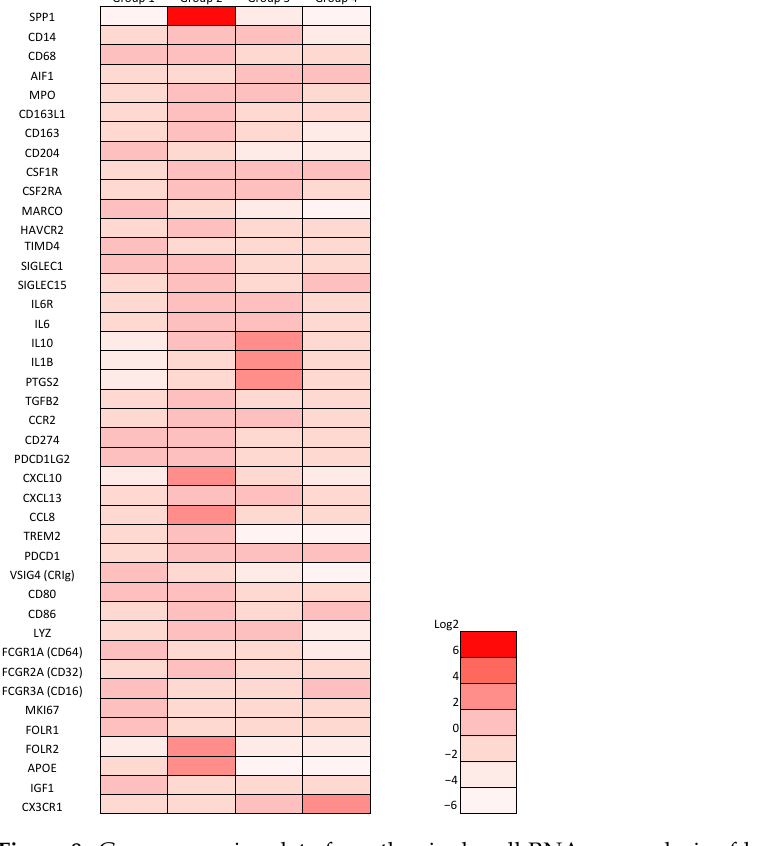
Figure 8. Gene expression data from the single-cell RNA-seq analysis of lung cancers published by